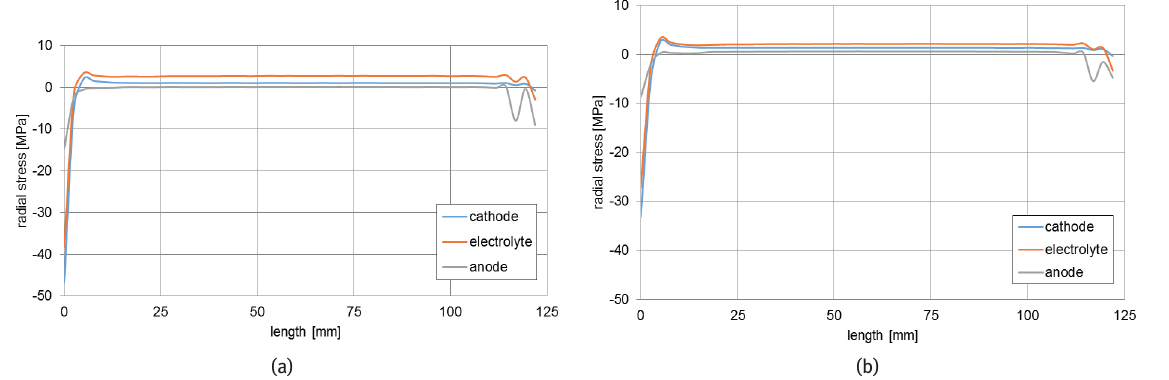
Figure 16: Distribution of operating radial stress of the mSOFC stack with supporting structure along the horizontal centerlines of each layer: (a) cross-section I, (b) cross-section